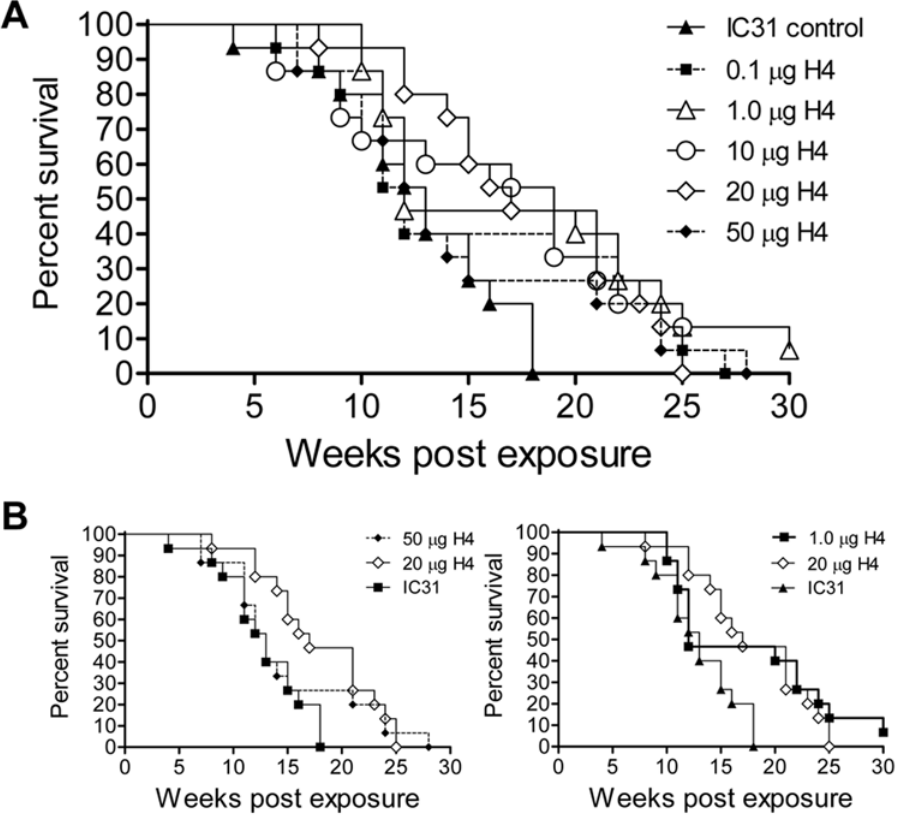
Figure 5. Kaplan-Meier plot of different doses of Ag85B-TB10.4 in the guinea pig TB model. (A and B). Groups of 15 animals per group were vaccinated three times with Ag85B-TB10.4 in IC31 H or with IC31 H alone (as a negative control). For antigen dose we used from 0.1 m g to 50 m g. 10 weeks after the last vaccination the animals were infected via the aerosol route with virulent M. tuberculosis , and monitored for weight loss post infection. B. Selected groups from the same experiment.